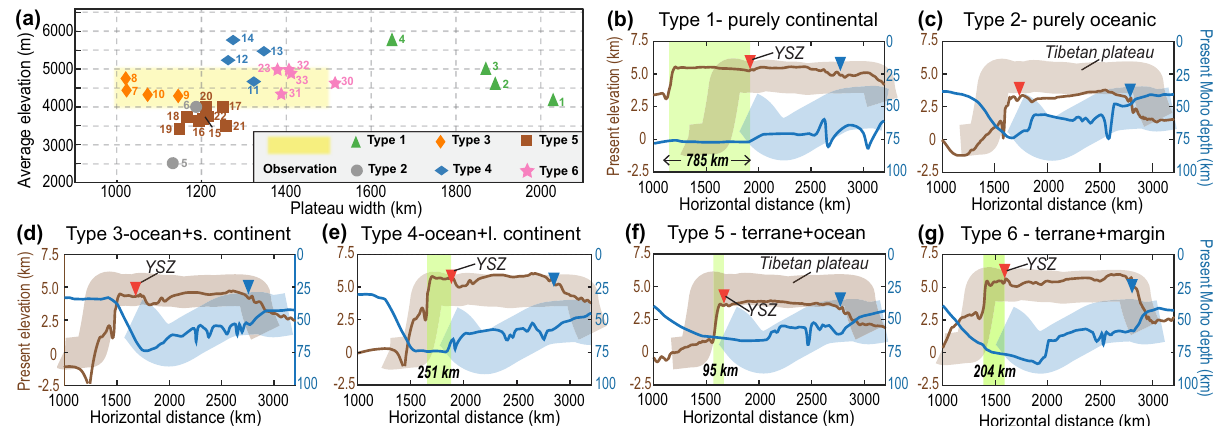
Fig. 6 | Present-day plateau morphology. a Plateau width (perpendicular to trench) and meanelevation.Numbersclose to symbolsdenote differentnumerical models (Table S2). b – g Plateau topography and Moho depth in Type 1 (Run 3, Figures S5c, S6c), Type 2 (Run 6, Figures S7b, S8b), Type 3 (Run 9, Figures S9c, S10c), Type 4 (Run 13, Figures S11c, S12c), Type 5 (Run 18, Figures S13d, S14d), and Type 6 (Run 23, Fig. 5) models, respectively. The thick background shadings illus- trate the topography and Moho distribution of the Tibetan Plateau (Fig. 2e). The